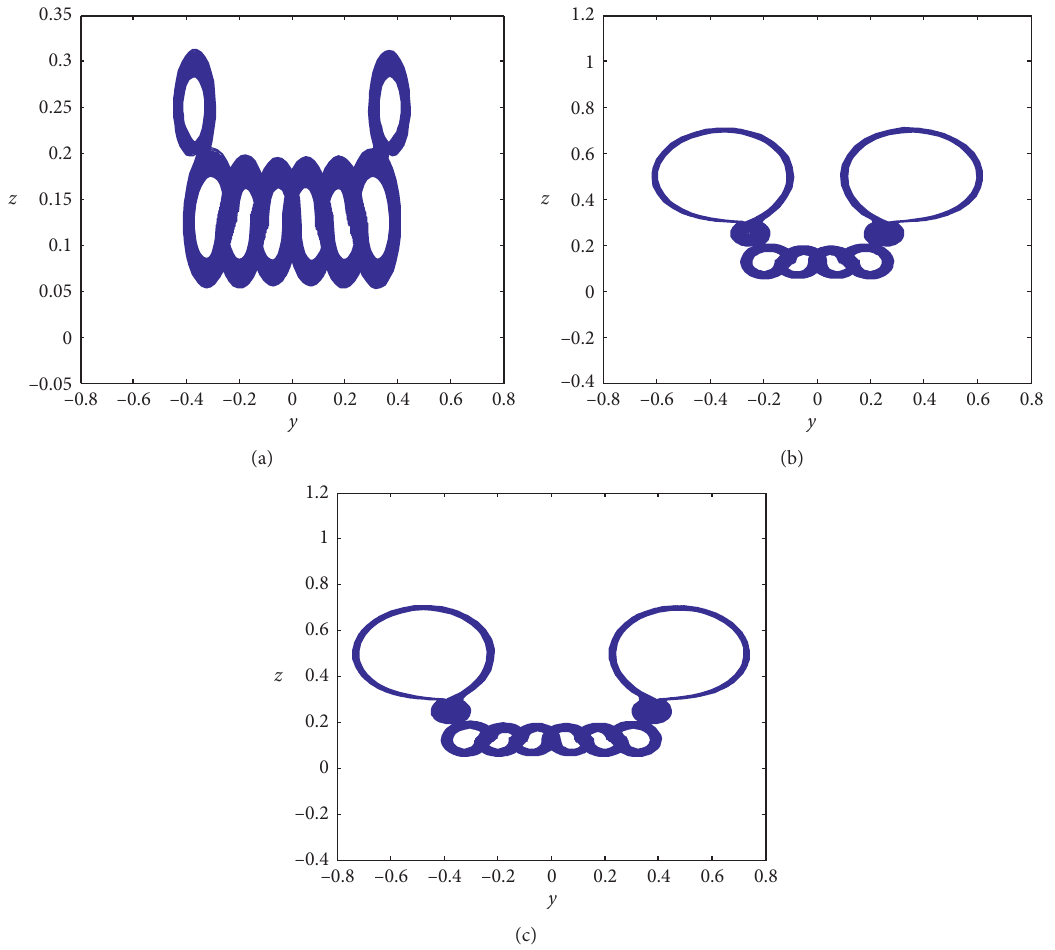
Figure 2: Numerical simulation results of saddle-shaped multiscroll chaotic attractors: (a) eight-scroll chaotic attractors for m � 2 and n � 1; (b) eight-scroll chaotic attractors for m � 1 and n � 2; (c) ten-scroll chaotic attractors for m � 2 and n � 2.